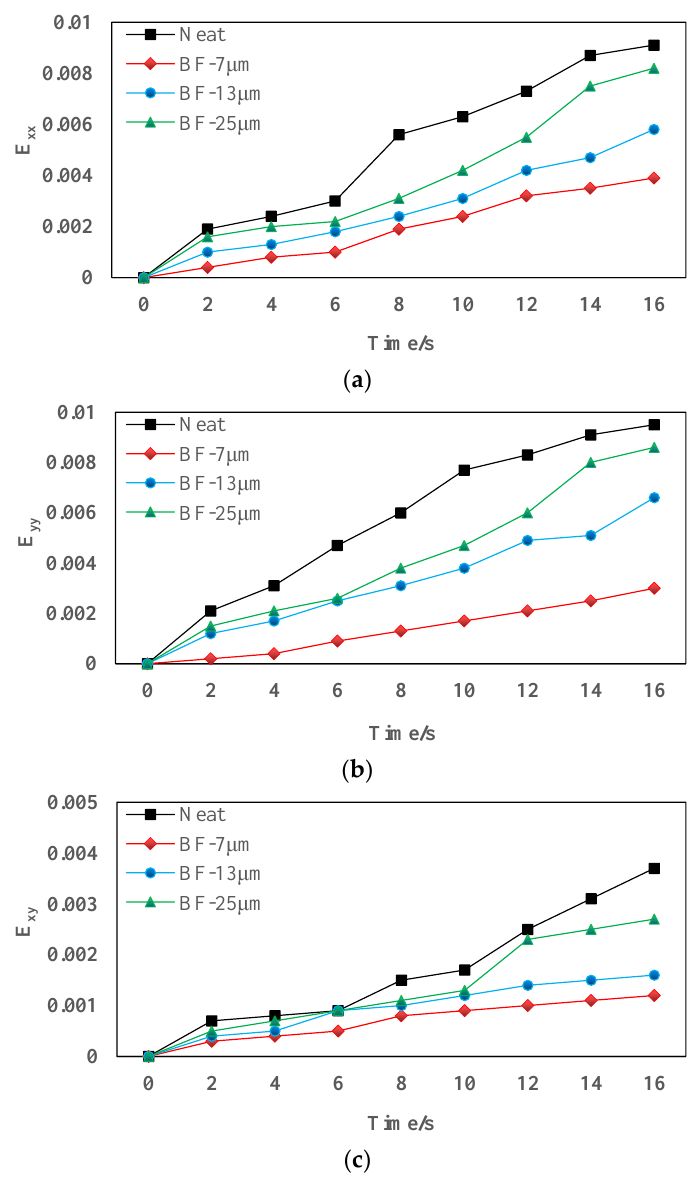
Figure 16. Strain test results of the specimen: ( a ) E xx ; ( b ) E yy ; ( c ) E xy .